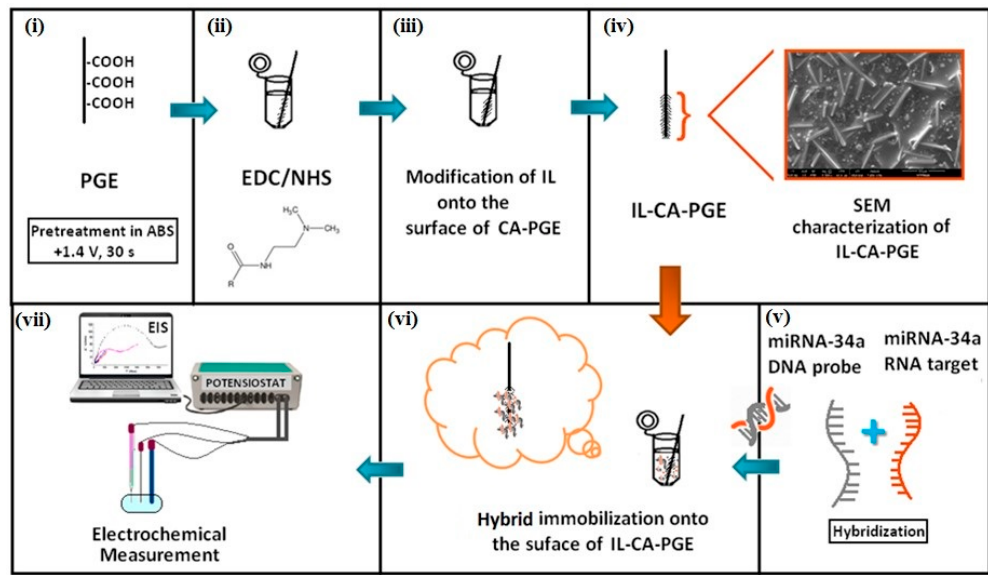
Figure 1. Experimental scheme presenting the pretreatment of PGE ( i ); the activation of PGE with EDC/NHS ( ii ), modification of IL onto the surface of CA/PGE ( iii ); microscobic characterization of electrodes ( iv ), the hybridization between miRNA-34a target and its complementary DNA probe ( v ); immobilization of the hybrids at the surface of IL/CA/PGE ( vi ); electrochemical measurement ( vii ).